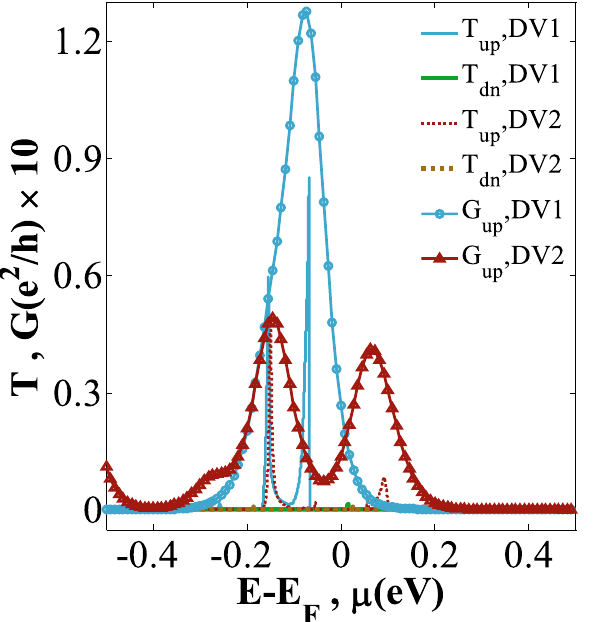
Figure 8. T up and T dn channels versus E - E F , and G up versus µ for the DV1and DV2 configurations, at T = 300 K,